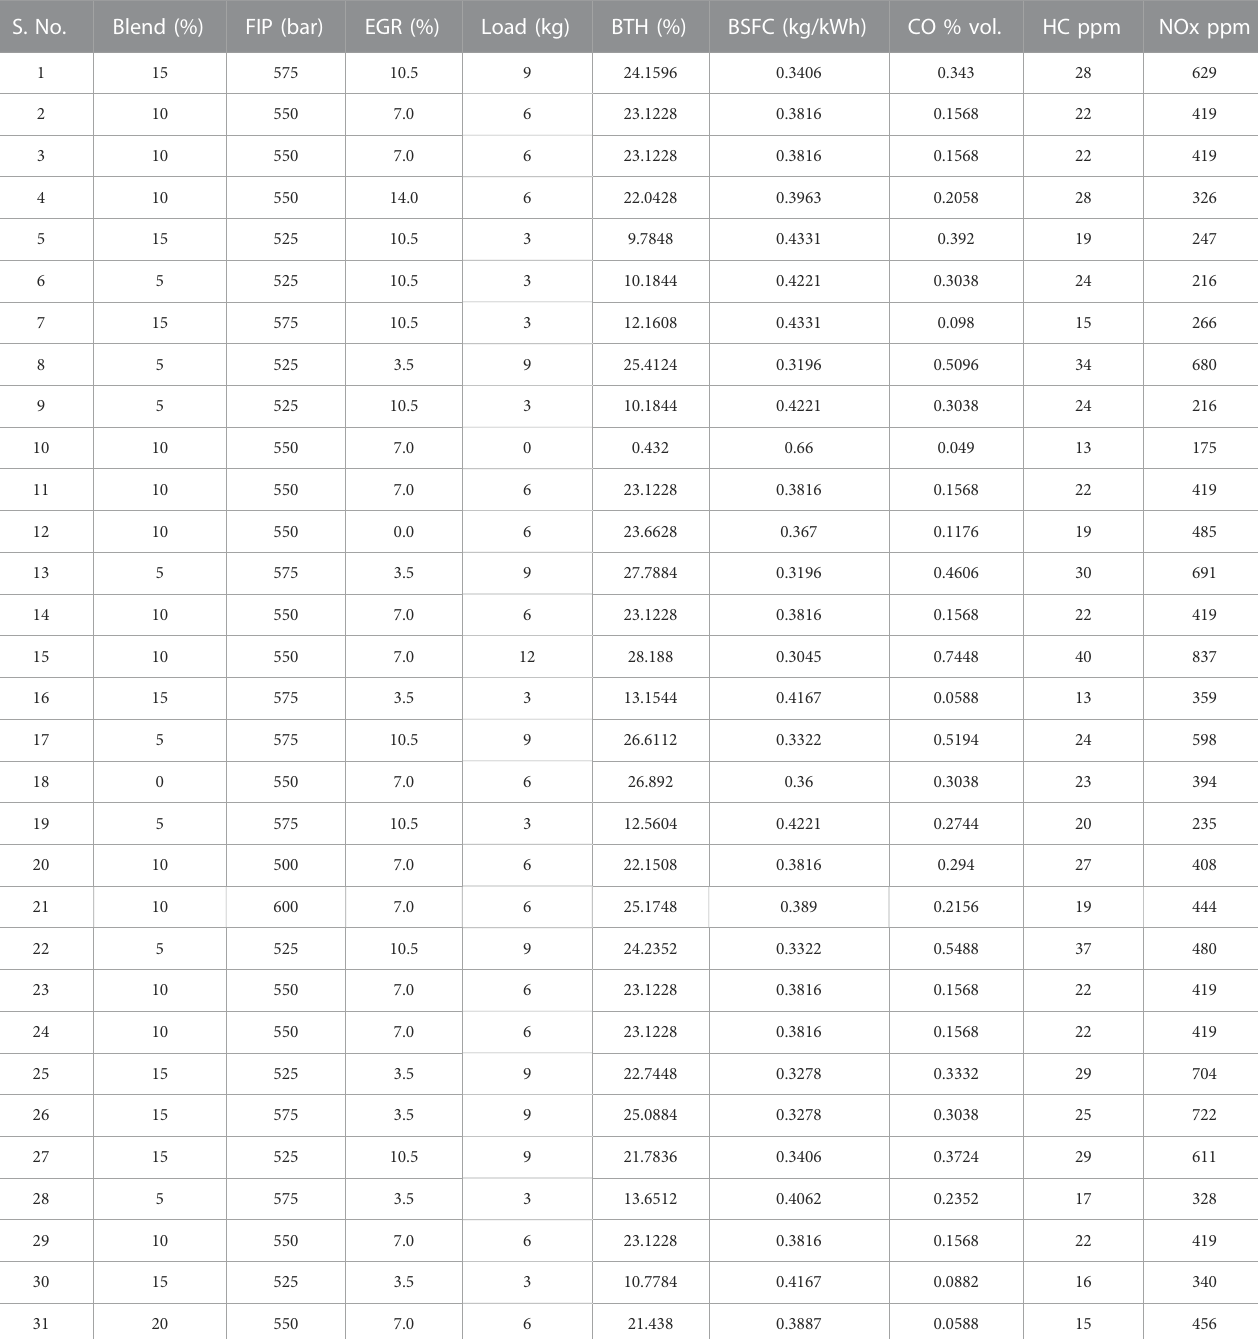
TABLE 6 The actual values of independent variables along with their output responses. S.